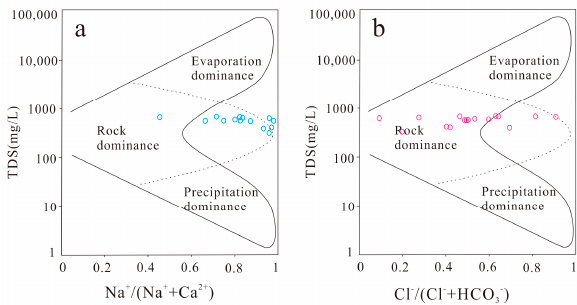
Figure 6. Gibbs diagram of the Taiyuan formation limestone water in the study area.